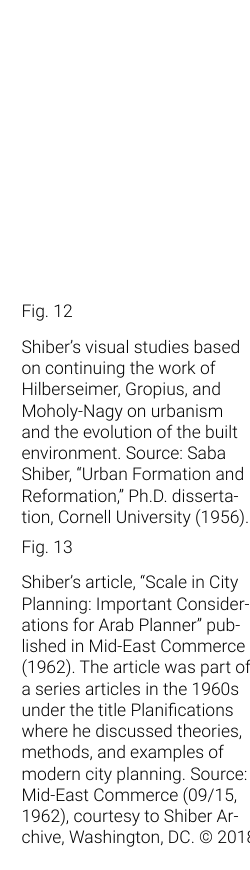
Shiber, “Urban Formation and Reformation,” Ph.D. disserta- tion, Cornell University